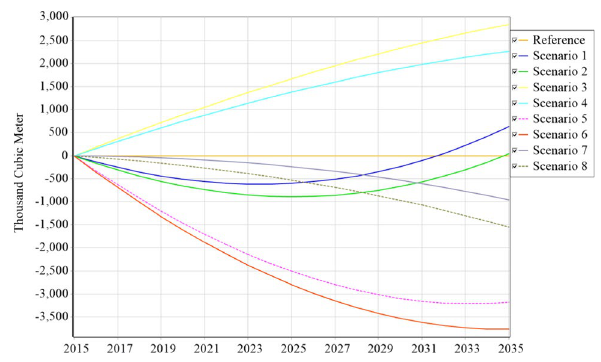
Fig. 6 Changes in water shortage at demand sites under scenario